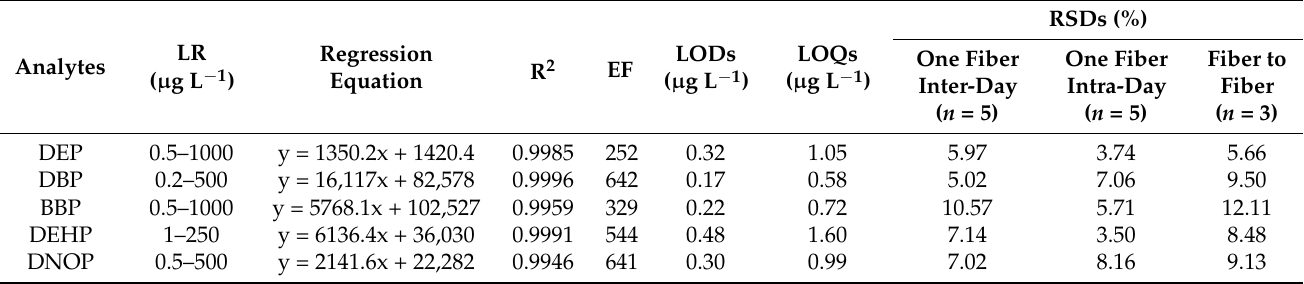
Table 1. Analytical performance of the ZIF-8/CA-coated fiber for the SPME of PAEs under the Table 2. Analytical results for the determination of five PAEs compounds in Huajing River and optimized conditions. bottled water samples.